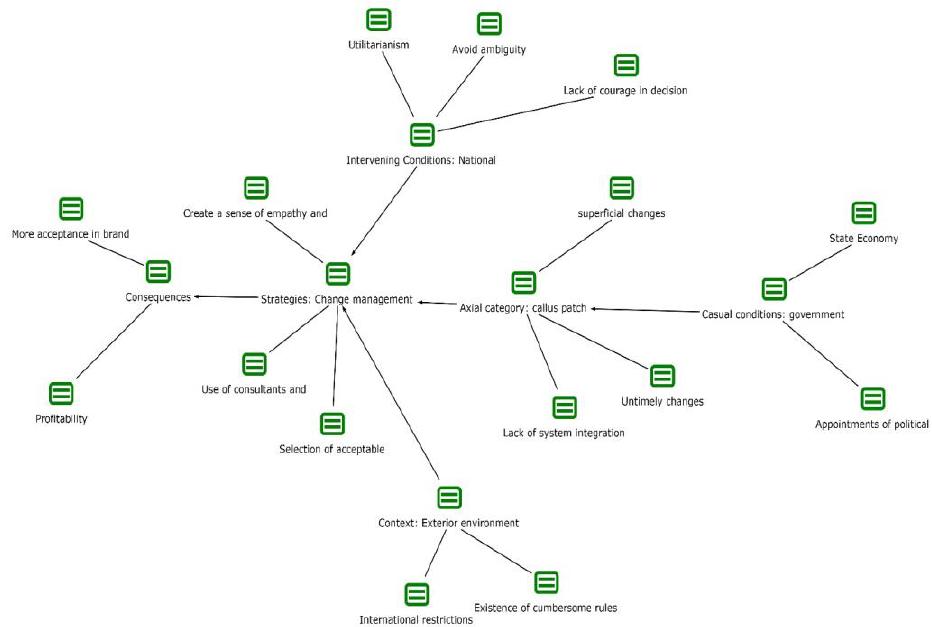
Figure 3: The proposed model based on axial